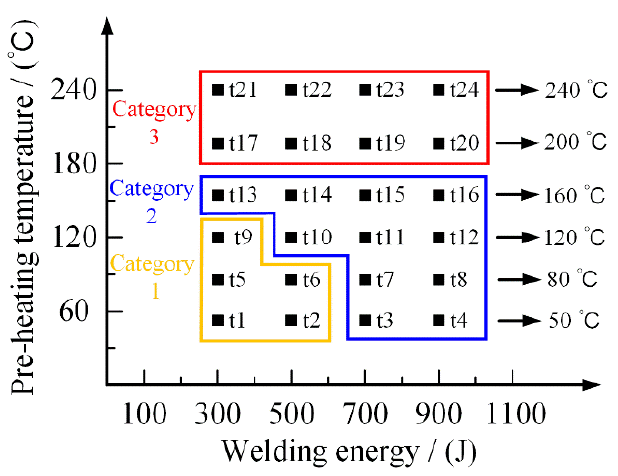
Figure 16. Ultimate lap shear strength of the joints under different joining parameters.